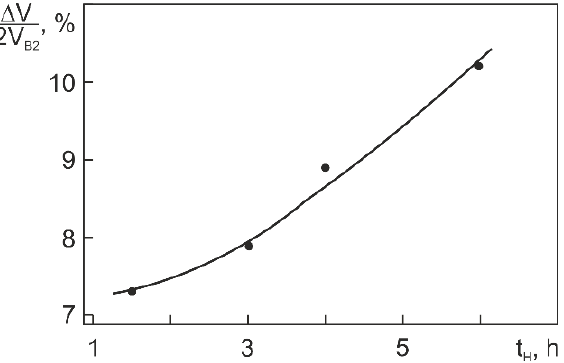
Figure 9. Volume change induced by orthorhombic hydride vs. hydrogenation time.